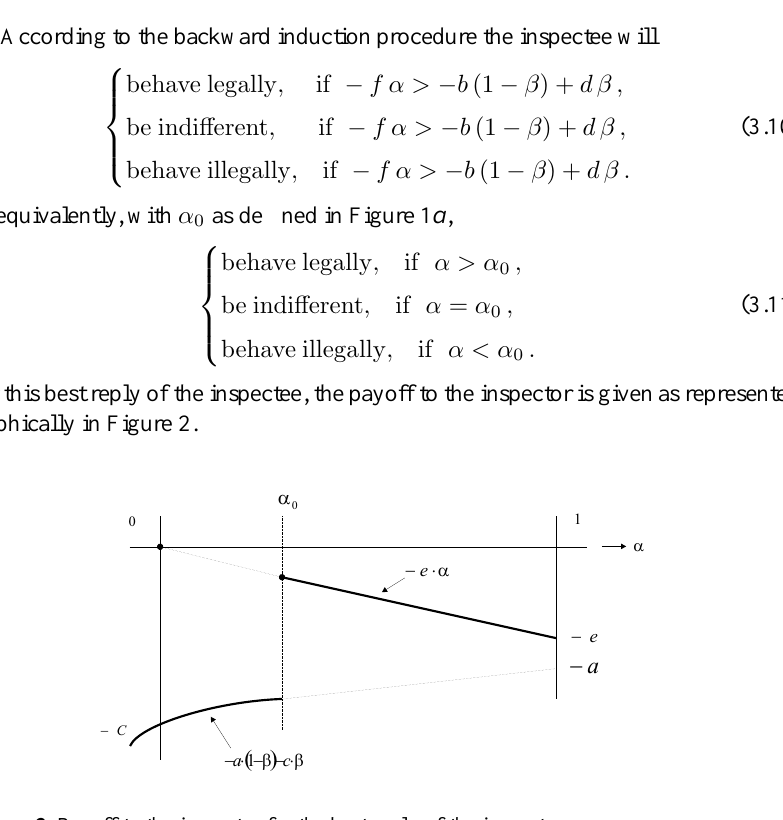
Figure 2. Payoff to the inspector for the best reply of the